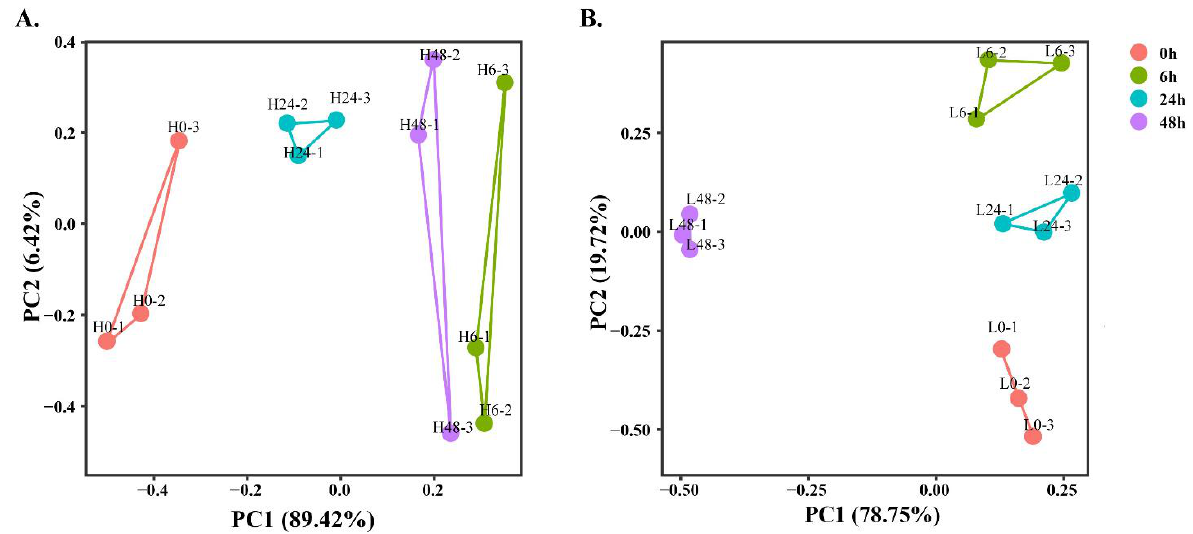
Figure 2. Principal component analysis of taste profiles on American shad muscle during storage: 24 ◦ C ( A ) and 4 ◦ C ( B ). 24 ◦ C: H, 4 ◦ C: Table 9. Taste profiles of American shad muscle at 24 °C (unrefrigerated) and 4 °C (refrigerated). Temperature